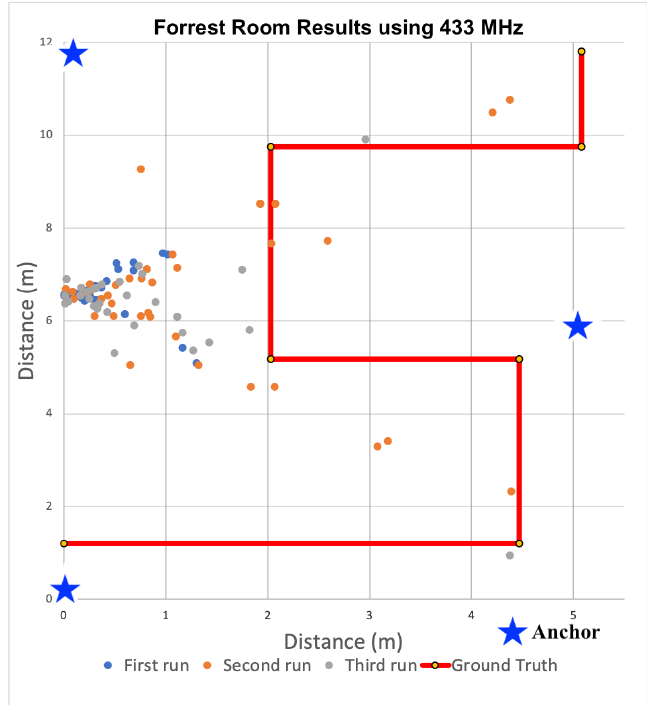
Figure 10. Position estimates obtained using RSS-based localization with 433 MHz transceivers in a mixed use space at the University. Reference anchor locations used for localization are shown as stars and the solid red line constitutes the ground truth path. The different colored points show the calculated positions while traversing the mixed use space during multiple successive experiments.